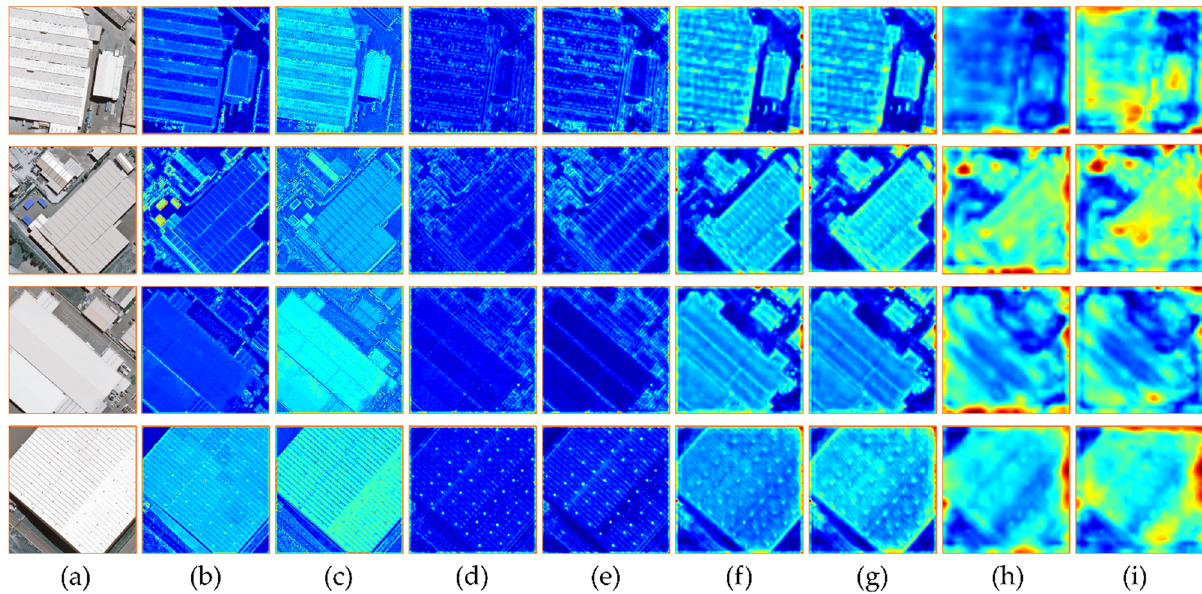
Figure 14. Visualization results of different levels of SA: ( a ) original images, ( b , c ) before and after SA_1, ( d , e ) before and after SA_2, ( f,g ) before and after SA_3, ( h , i ) before and after SA_4.